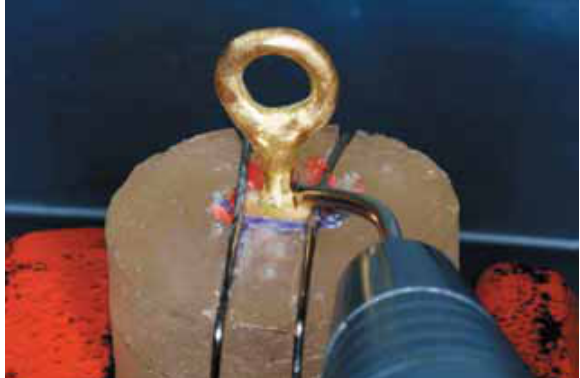
Figure 2- Custom cast dowel and core luted in a sample with simulated periodontal ligament. Note the presence of two wires in order to prevent the root dislodgement during testing